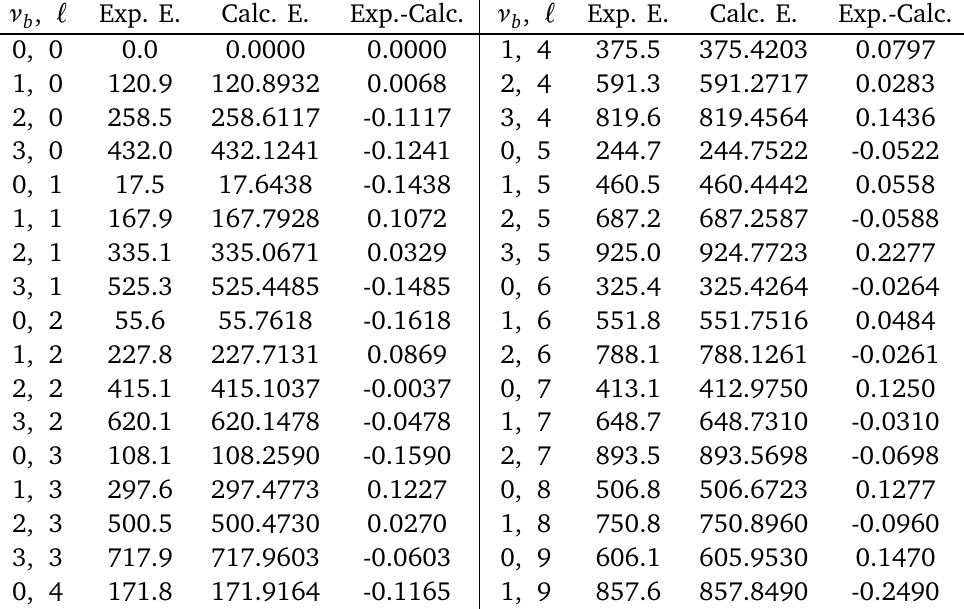
Table 3: Experimental [ 120 ] and calculated band origins and residuals for the ClCN bending mode of 37 ClCNO. Units of cm − 1 .